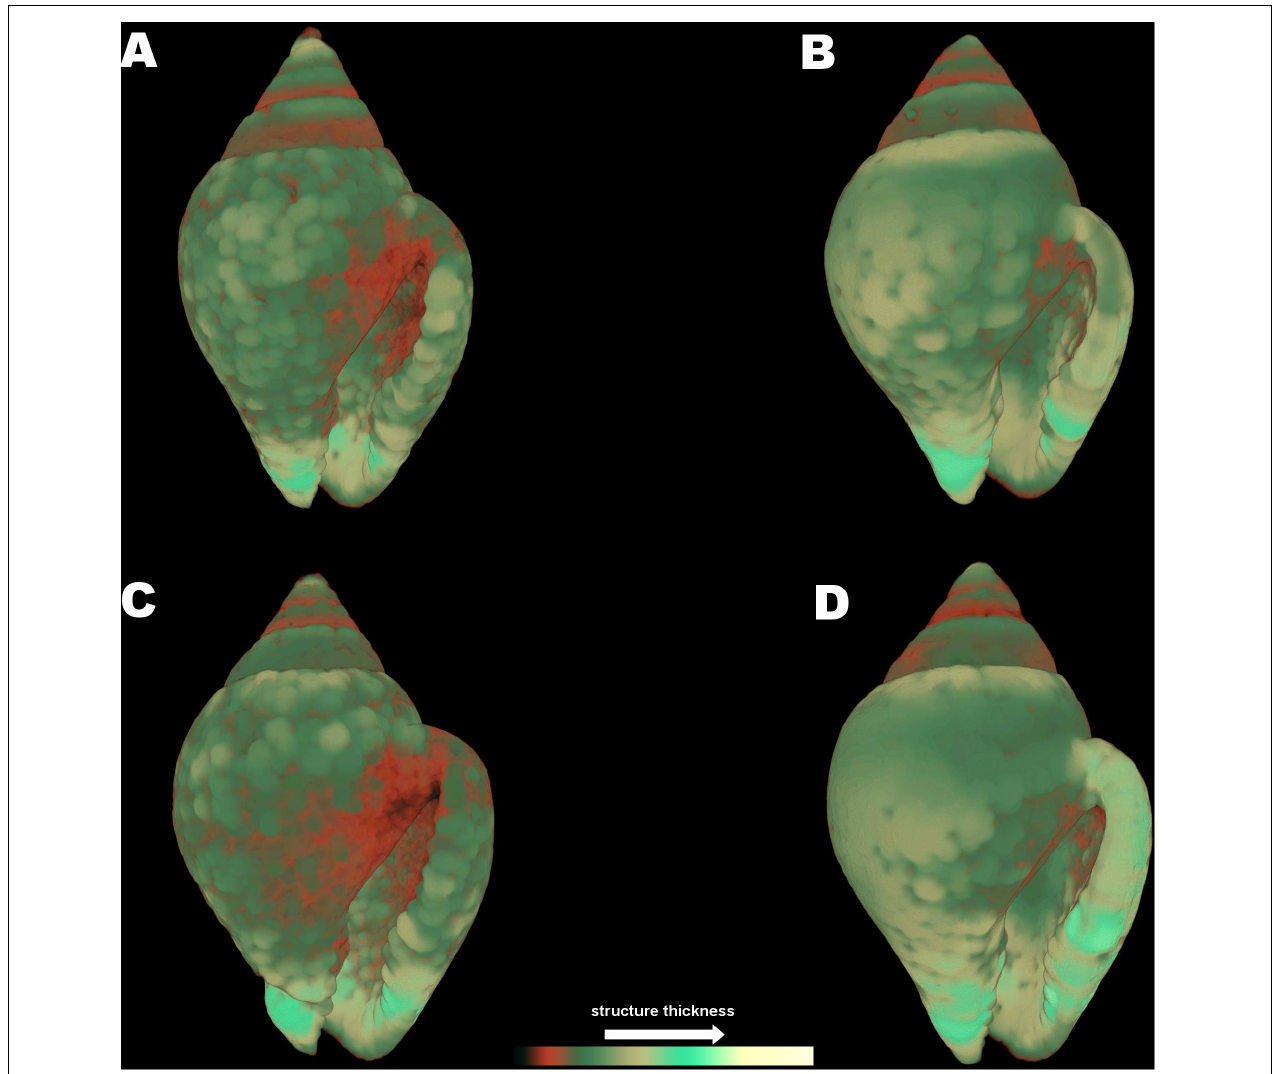
FIGURE 7 | Color coded visualization of shell structure thickness for Columbella rustica in the four experimental treatments (A) (7A), (B) (8A), (C) (7W), and (D) (8W) as coded in the text (8A: 20 ◦ C and pH = 8; 7A: 20 ◦ C and pH = 7.7; 8W: 23 ◦ C and pH = 8; 7W: 23 ◦ C and pH = 7.7). The bar on the bottom of the image indicates thickness scaling (cooler colors indicate thicker structures, warmer colors indicate thinner